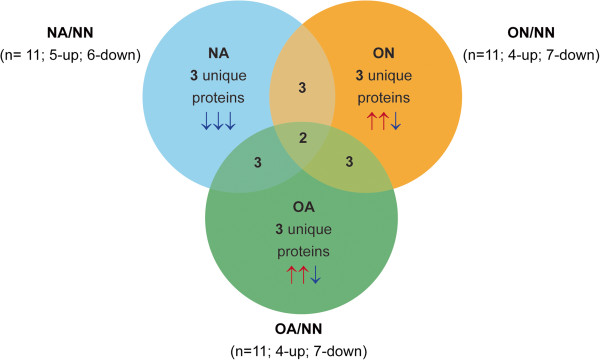
Venn diagram showing distribution of 20 differentially expressed proteins. This was based on the NSC ratio cut-off >2 across 3 samples, NA, OA, and ON in comparison to the baseline NN sample.